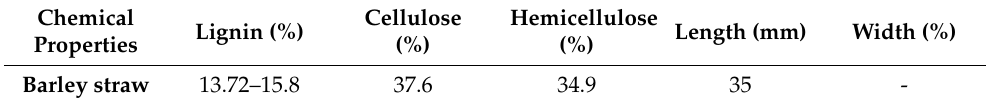
Table 12. Natural fiber chemical and morphological characteristics of WSA [97,98].